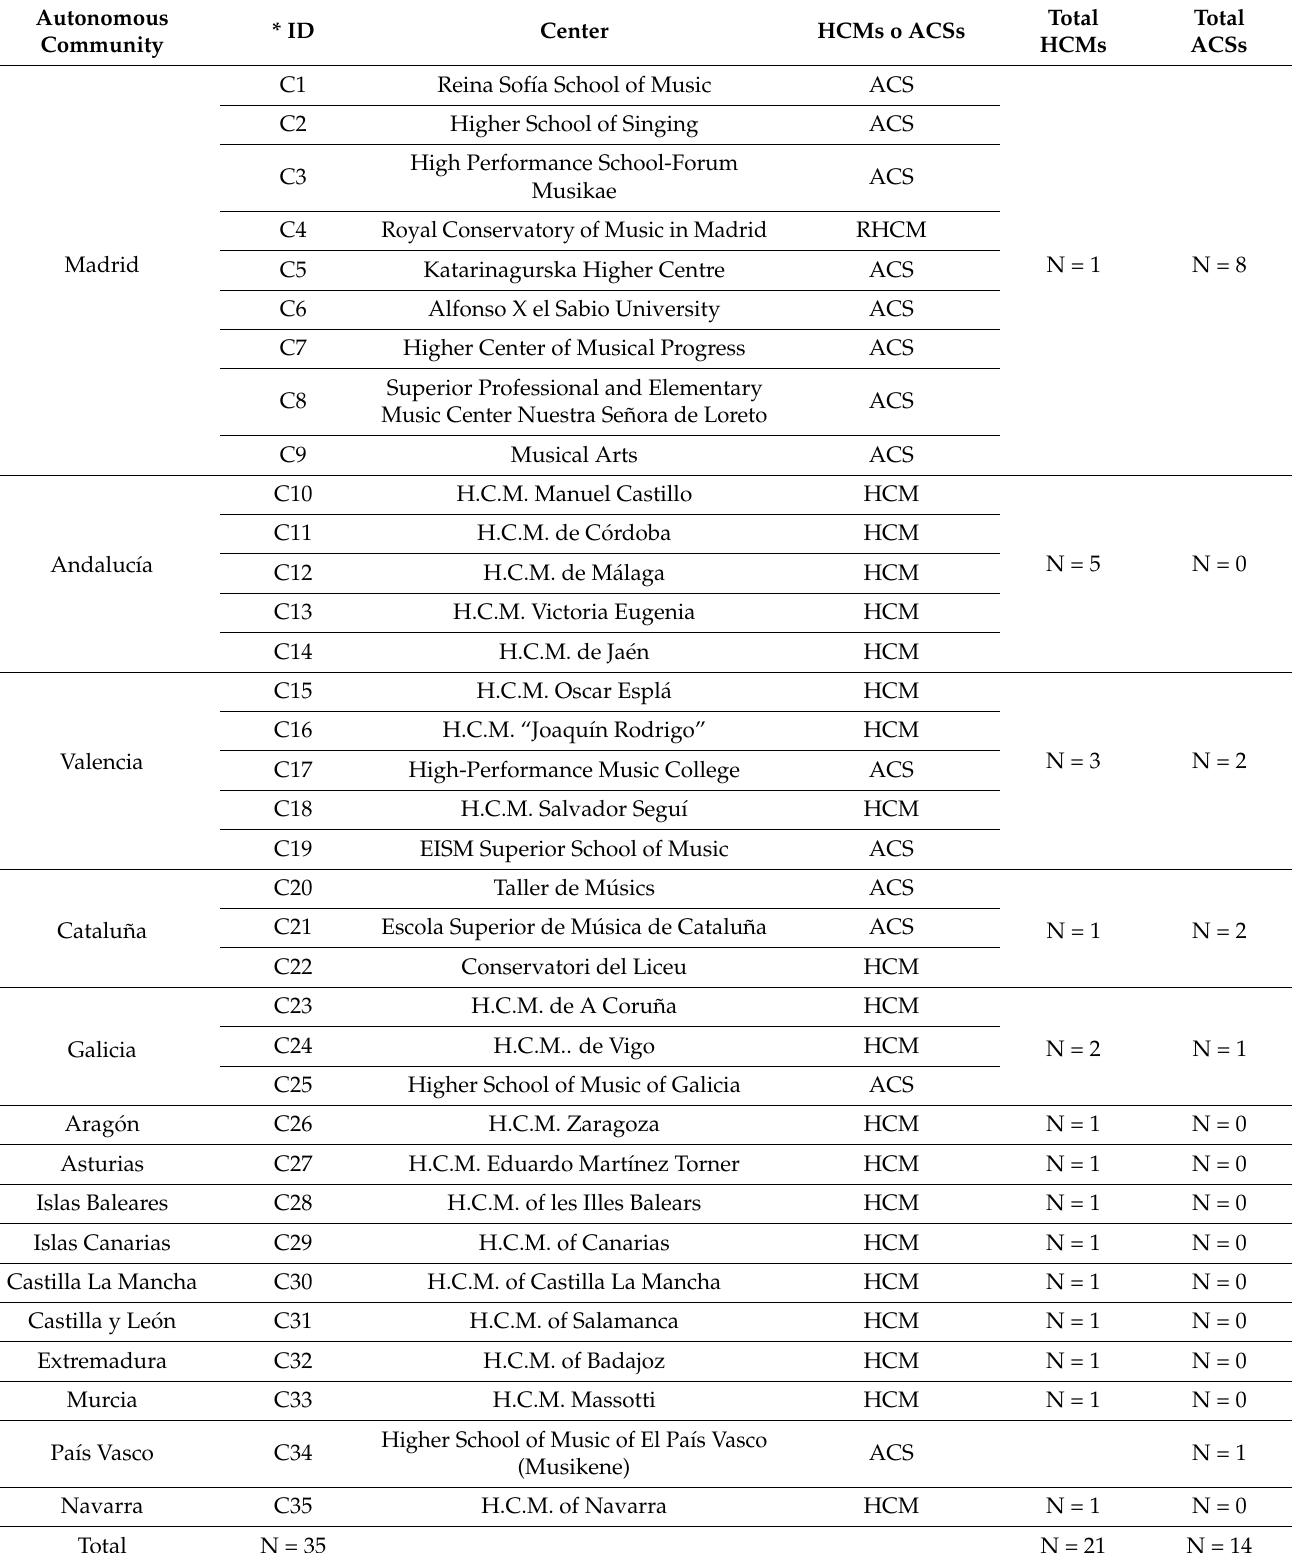
Table 2. HCMs and ACSs in